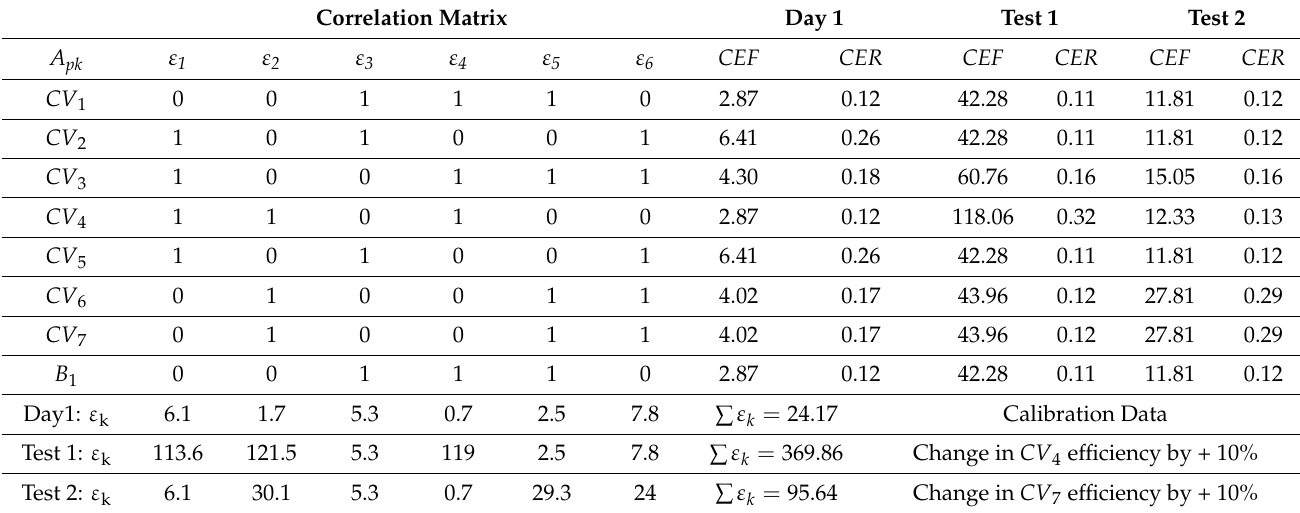
Table 6. Testing of CEF and CER values for hypothetical test cases. Correlation